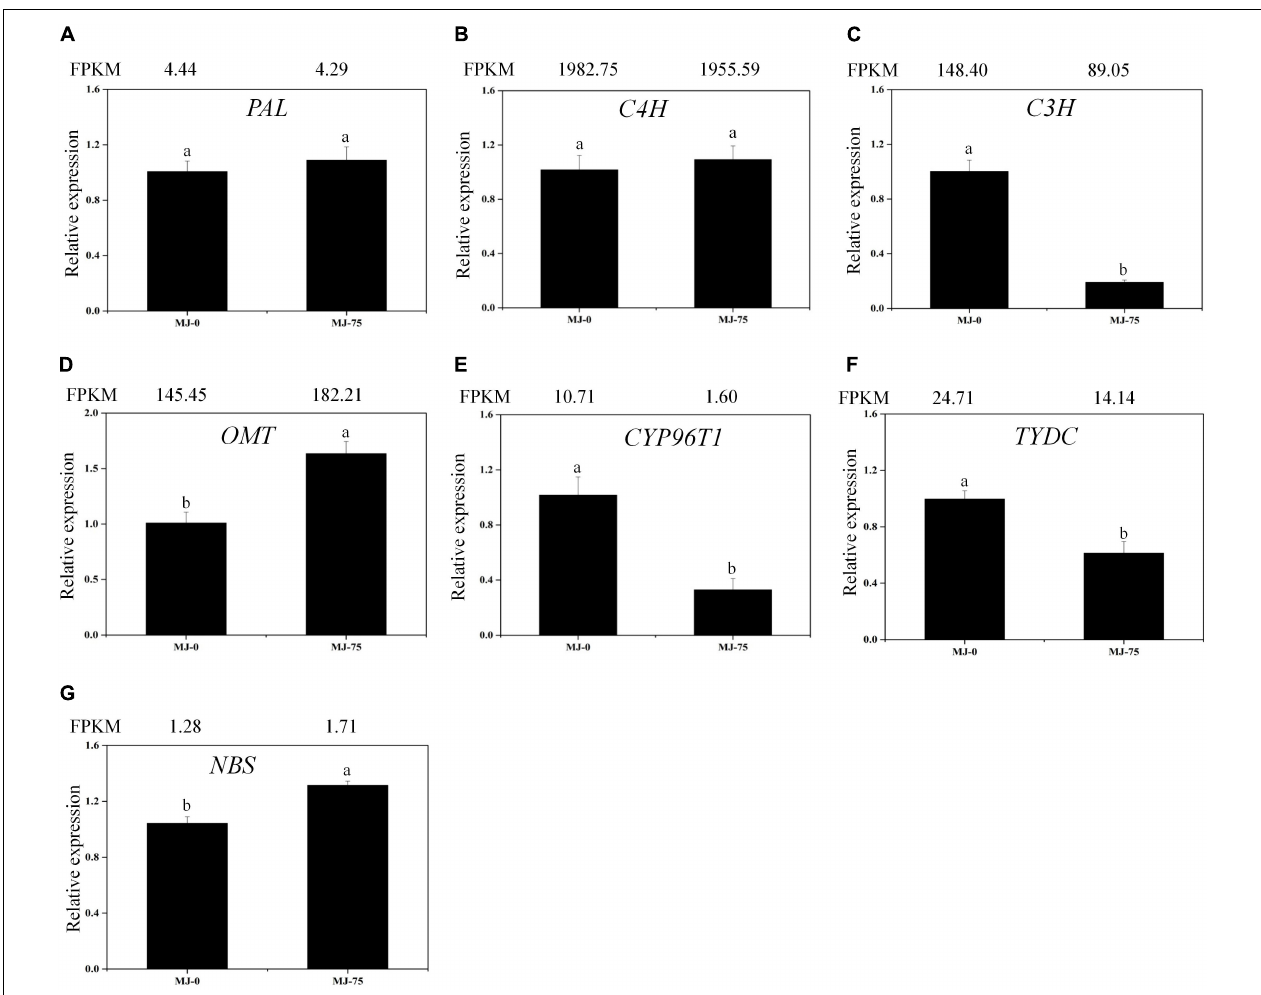
FIGURE 7 | Expression analysis of the DEGs involved in Gal biosynthesis in the different MJ treated L. longituba seedlings. RT-qPCR analysis of PAL (A) , C4H (B) , C3H (C) , OMT (D) , CYP96T1 (E) , TYDC (F) , and NBS (G) . The bar chart shows the relative expression levels as measured by RT-qPCR values, while the top vertical axis shows the relative RPKM values. Error values indicate the standard deviation (SD). C3H, p -coumarate 3-hydroxylase; C4H, Cinnamate-4-hydroxylase; CYP96T1, noroxomaritidine synthase; DEGs, differentially expressed genes; NBS, norbelladine synthase; OMT, norbelladine 4 (cid:48) -O-methyltransferase; PAL, phenylalanine ammonia; RPKM, Reads Per Kilobase per Million mapped reads; RT-qPCR, real-time quantitative polymerase chain reaction; TYDC, tyrosine decarboxylase. Least-significant difference test (LSD, p < 0.05) was used to compare the means. Different letters represent significant differences between groups ( N = 3, p <